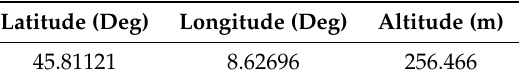
Figure 1. Environment where the antenna was placed for the static test. GNSS signals are degraded by multipath due to the buildings surrounding the receiver. Table 1. Coordinates of the antenna placed in a parking area at the Joint Research Centre (JRC) premises in Ispra, Italy.